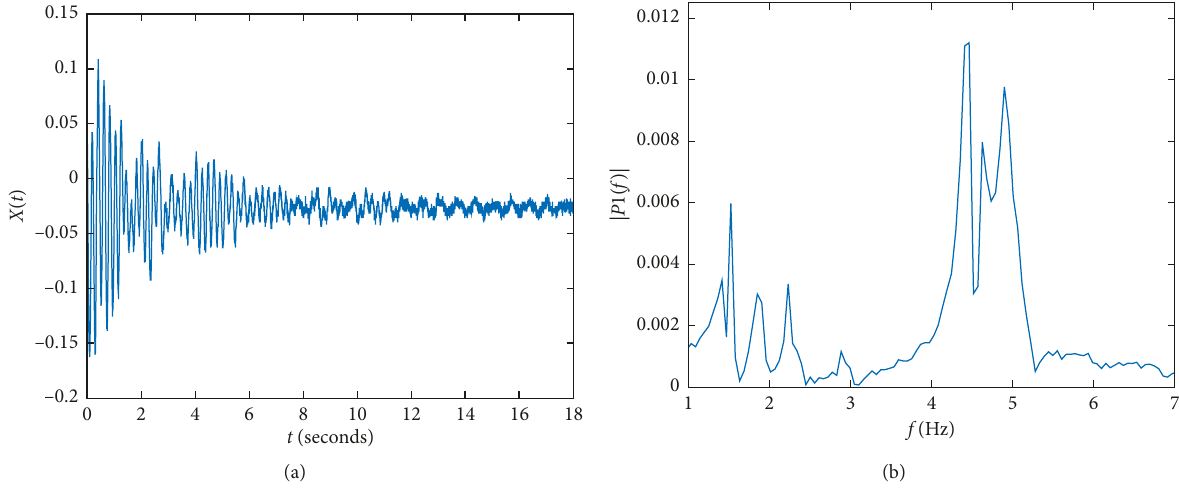
Figure 4: Measured tiltmeter signal and FFT when the vehicles left: (a) time history and (b) FFT of the tiltmeter signal.